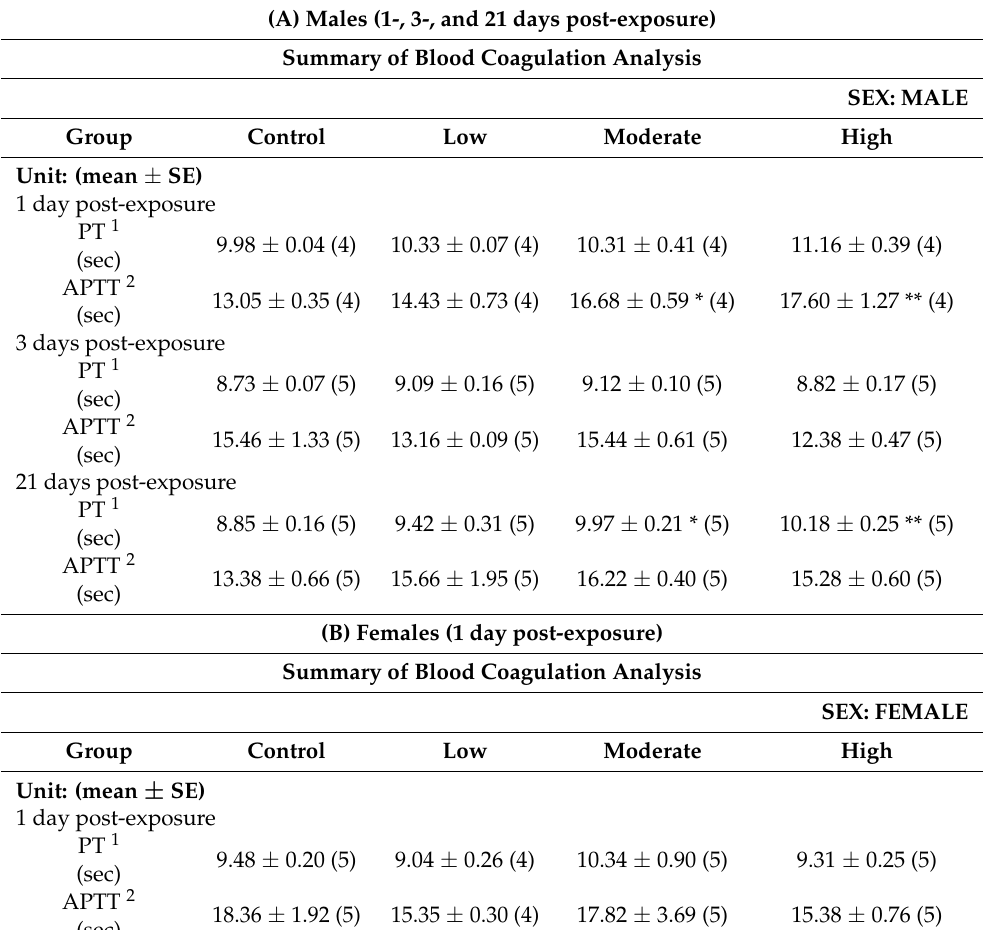
Table 6. Blood coagulation at 1, 3, and 21 days after CNF